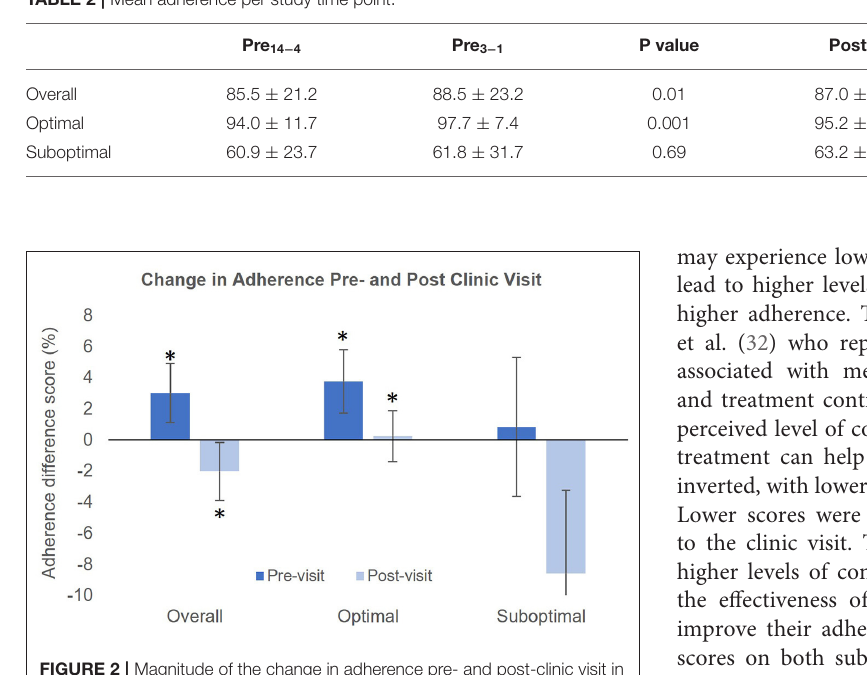
FIGURE 2 | Magnitude of the change in adherence pre- and post-clinic visit in the study population. Asterisks indicate significant differences between the Pre 14 − 4 and Pre 3 − 1 or between Post 1 − 3 and Post 4 − 14